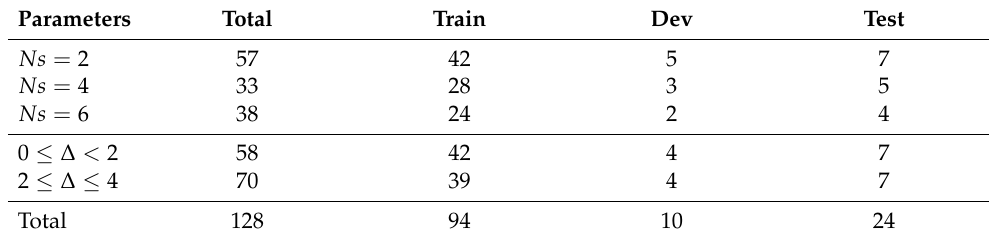
Table 1. Distribution of parameters within phase